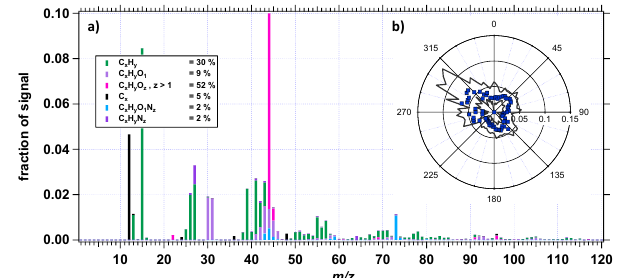
Fig. 17. (a) Speciated organic mass spectrum of M-OOA and (b) wind rose of M-OOA mass concentrations in µgm − 3 . The blue markers indicate the median concentration while the black lines de- note the 25th and 75th